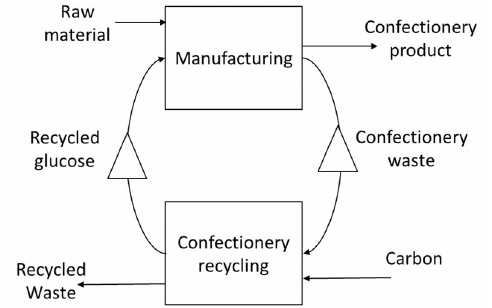
Figure 2. Confectionery factory processes connected with I/O